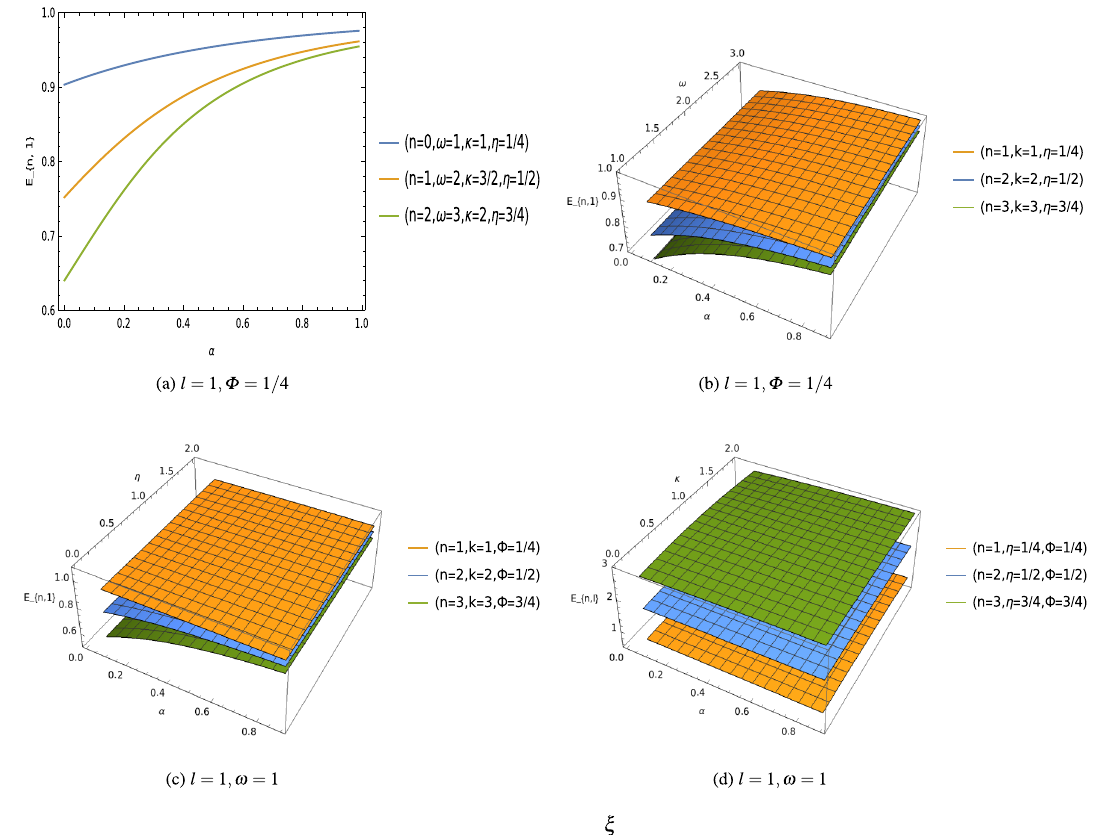
Figure 4. Energy E n , l with parameters keeping fixed M = 1 = b = e , ξ = 1 / 2 [units of different parameters are chosen in natural units ( c = 1 = (cid:31) )